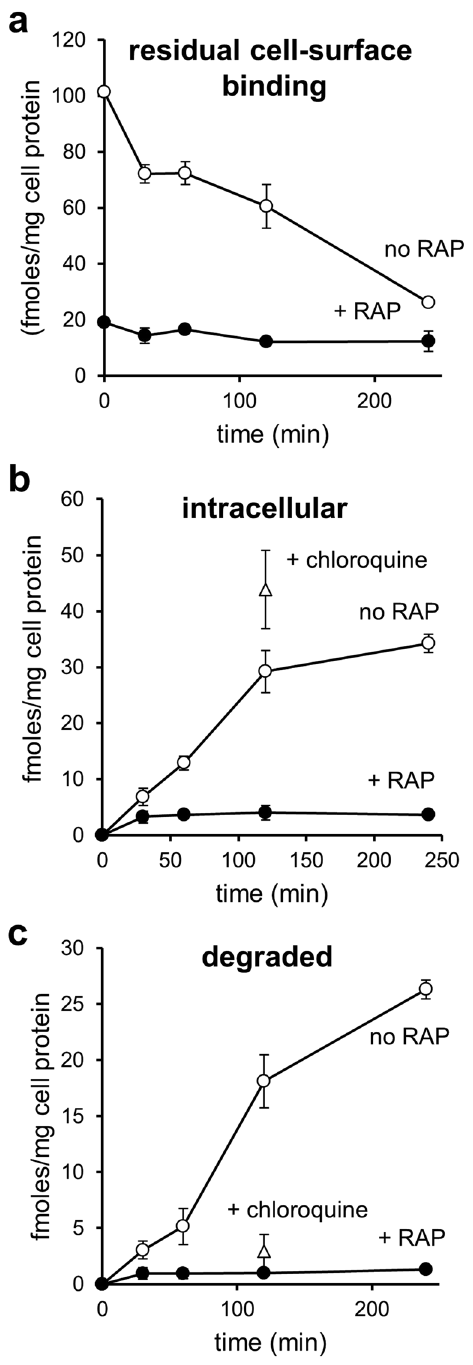
Figure 4. Uptake and degradation of 125 I- proMMP-2:TIMP-2 complex by rat yolk sac BN16 cells. BN16 cells were incubated with 10 nM 125 I-proMMP-2:TIMP-2 complex at 4 °C for 2 h to allow surface binding, in the absence (open circles) or presence of 1 μ M RAP (closed circles). Some of the cultures were pre-treated with 100 μ M chloroquine for 1 h at 37 °C (open triangles). After washing, cells were further incubated with fresh medium pre- warmed at 37 °C, without or with RAP or chloroquine as above. At the indicated times, the amounts of ligand ( a ) remaining surface-bound (pronase ® -sensitive radioactivity), ( b ) internalized (pronase ® -resistant radioactivity) and ( c ) degraded (trichloroacetic acid-soluble radioactivity in conditioned medium) were measured. Values are means ± S.D. of three dishes. This experiment was performed twice with similar